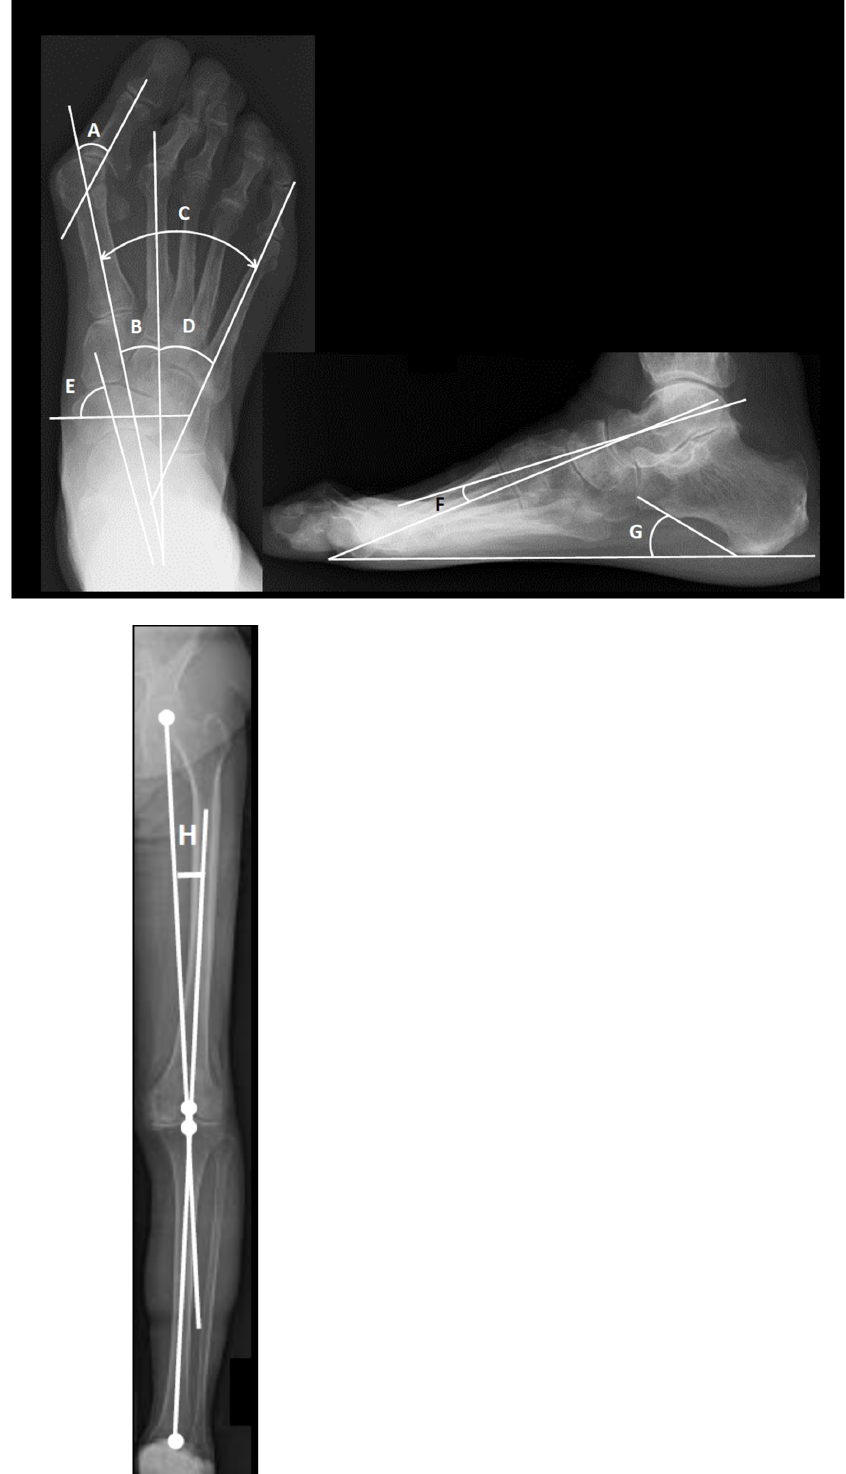
Figure 1. Radiograph to measure parameters of foot deformity. ( A ) Hallux valgus (HV) an- gle. ( B ) Intermetatarsal angle between the first and second metatarsal bones (M1-M2A). ( C ) In- termetatarsal angle between the first and fifth metatarsal bones (M1-M5A). ( D ) Intermetatarsal angle between the second and fifth metatarsal bones (M2-M5A). ( E ) Pronated foot index (PFI: angle).